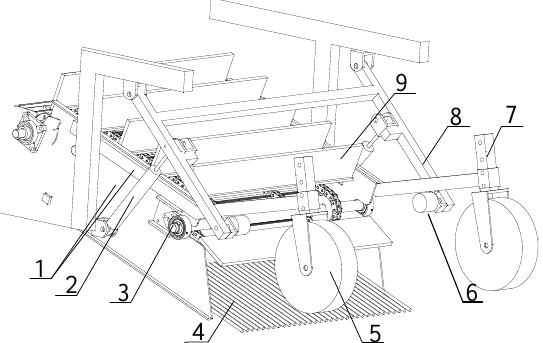
Figure 2. Schematic diagram of the pickup device. 1. Pickup side plate. 2. Hydraulic cylinder. 3. Strip brush roller shaft. 4. Comb teeth. 5. Profile wheel. 6. Rolling pulley. 7. Profile adjusting rod. 8. Lifting rod. 9. Strip brush.